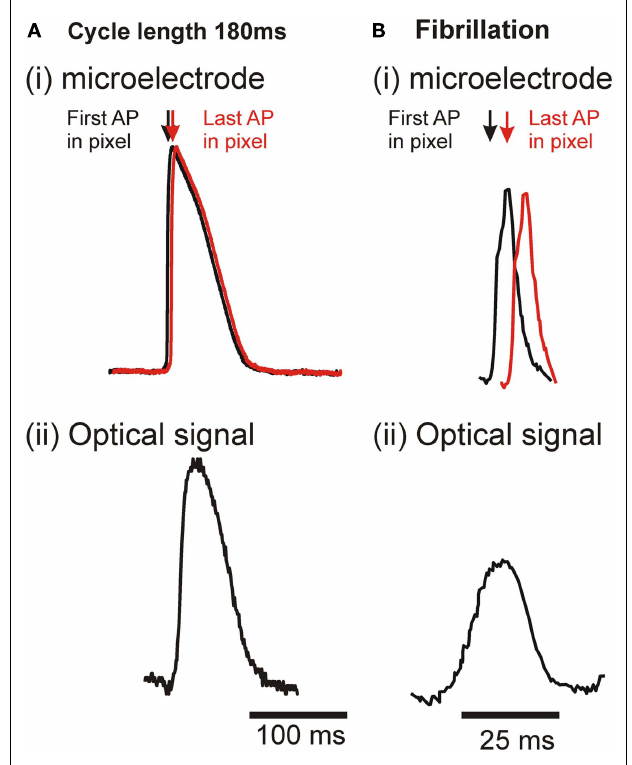
FIGURE 8 | Illustration of earliest and latest activation within a single pixel in regular pacing andVF and the effect on resultant optical signal. (A) During regular pacing. (i) transmembrane AP – assuming CV = 50cm/s across the ∼ 1mm 2 pixel, the maximal delay between the first and last activation would be ∼ 2ms. (ii) Resultant optical signal from a single pixel. (B) DuringVF. (i) transmembrane AP – with greatly reduced APD.The reduced CV of ∼ 35cm/s increases the maximal delay to ∼ 3.5ms. (ii) Resultant optical signal from a single